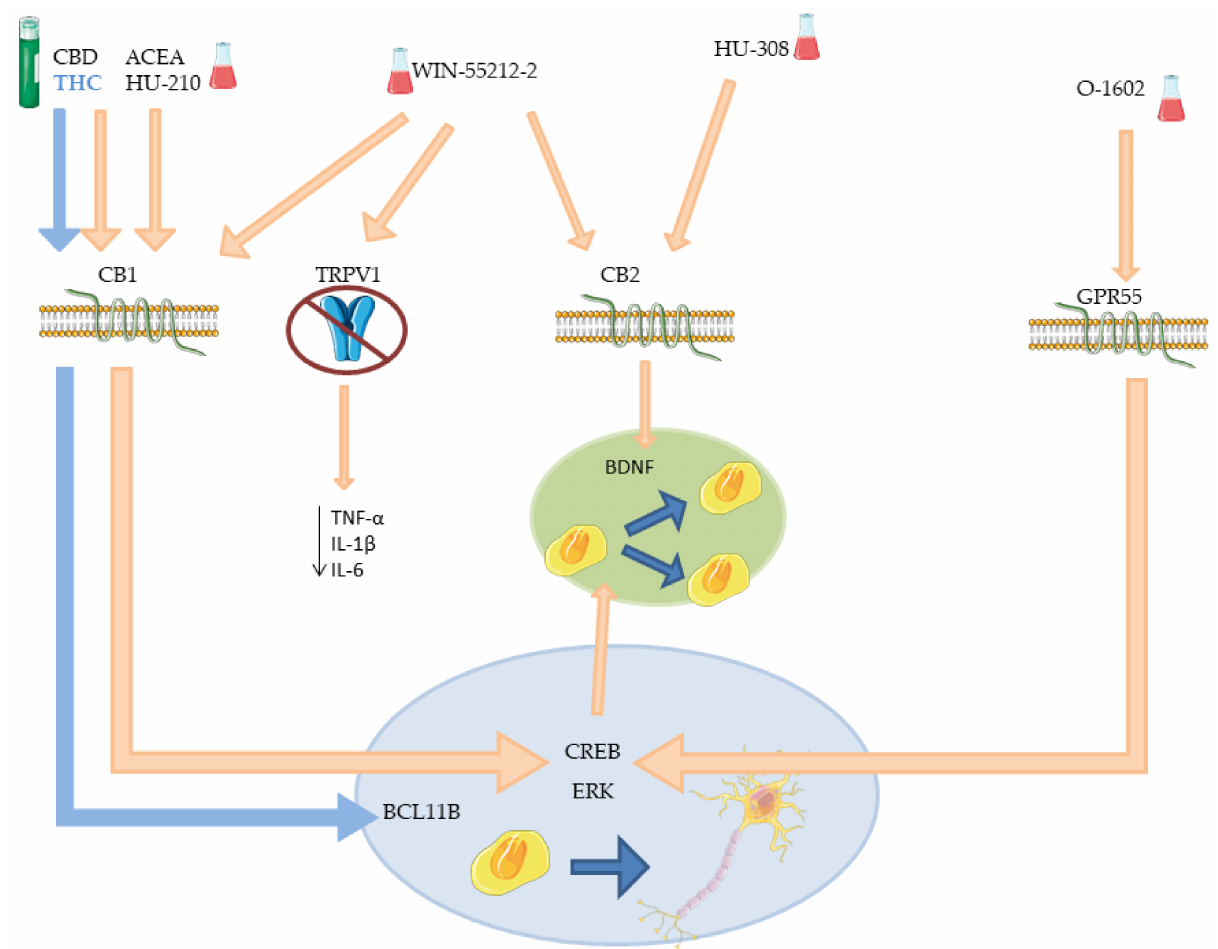
Figure 4. Mechanism of different phyto- and synthetic cannabinoids on neurogenesis. The picture offers a schematic representation of the receptors involved in neurogenesis and their signal cascade activated after agonist action of phyto- or synthetic cannabinoids, tested on cells or animals which do not resemble any specific disease. THC effect on BCL11B is highlighted in blue. BCL11B: B-cell lymphoma/leukemia 11B; BDNF: brain-derived neurotrophic factor; CB1: cannabinoid receptor 1; CB2: cannabinoid receptor 2; CBD: cannabidiol; CREB: cAMP response element-binding protein; ERK: extracel- lular signal-regulated kinases; GRP55: G protein-coupled receptor 55; IL-1 β : interleukin 1 beta; IL-6: interleukin 6; THC: ∆ 9 -tetrahydrocannabinol; TRPV1: transient receptor potential cation channel subfamily V member